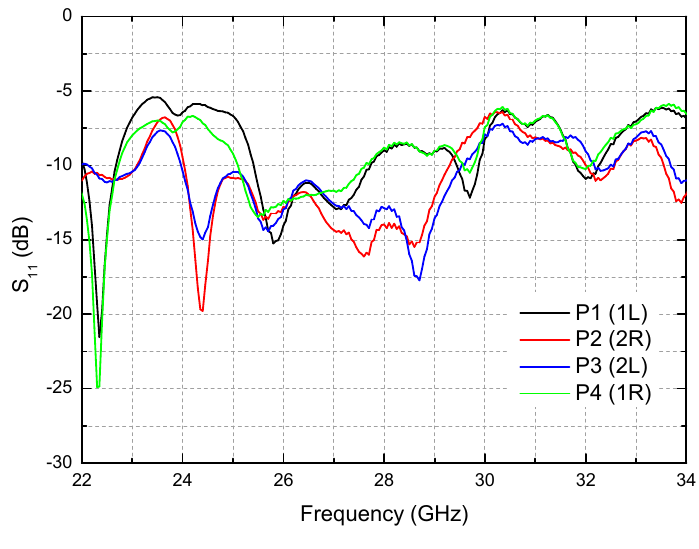
Figure 7. Measured S 11 .